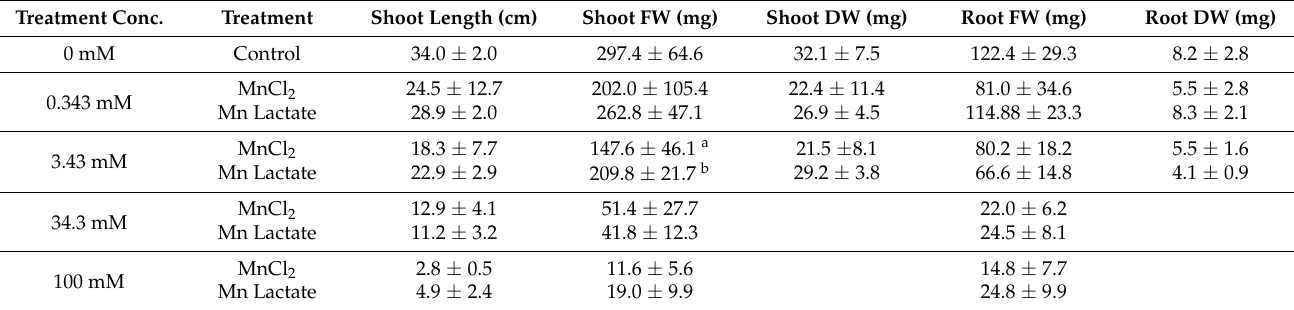
Table 3. Plant growth parameter results for manganese (Mn) treatments. After 13 days of growth, wheat seedlings were harvested, and shoot length was measured along with fresh weight (FW) and dry weight (DW) of both root and shoot tissue. A t -test was used to identify differences between manganese chloride and manganese lactate treatments within each treatment level for each plant growth parameter, where superscripts “a” and “b” denote treatment differences of p < 0.05. ± : standard deviation.